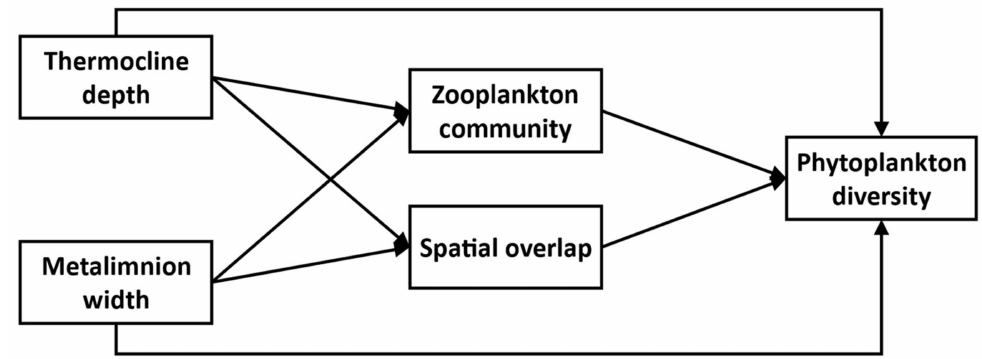
Figure 1. Initial Structural Equation Model. Each box represents a variable, and each arrow is a hypothesized